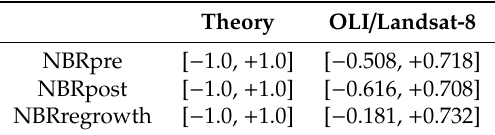
Table 4. Theory and observed bands, considering the pixels corresponding to the NBR indices for the fire close to Mucugê. Theory OLI/Landsat-8